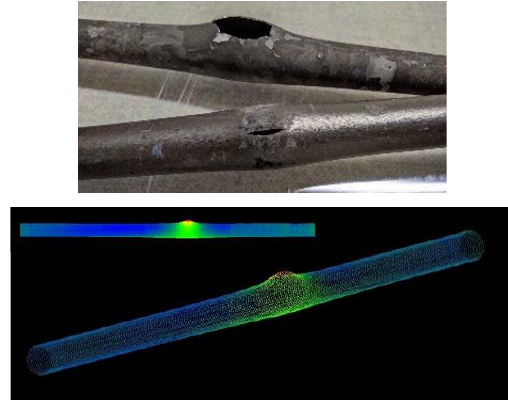
Fig. 8. Post-test examination results. Top: final aspect of burst dummy rods (pre-oxidised Zircaloy cladding, Al 2 O 3 pellets, after several ramps). Bottom: 3D post-test laser